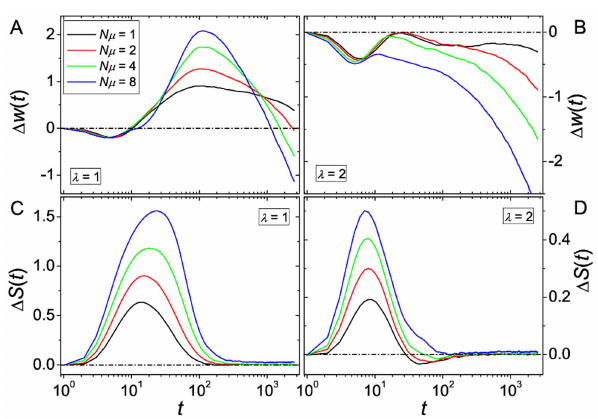
Figure 3. Dependence of the recombinational advantage on mutation supply. The figure shows time series of mean fitness difference D w (A, B) and entropy difference D S (C, D) for varying mutation rate m and two different values of the ruggedness parameter l . The population size is N ~ 1000 and c ~ 1 .